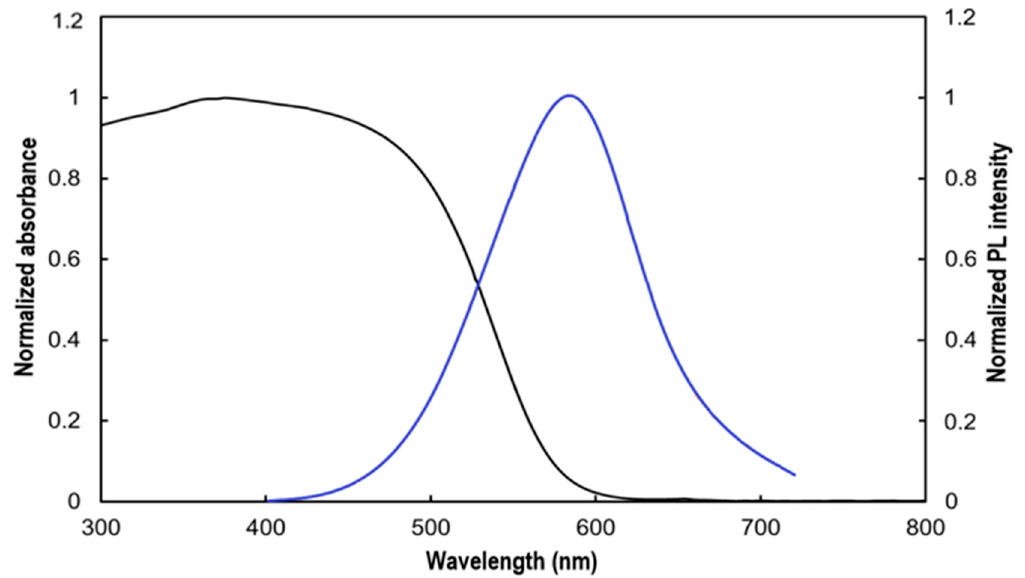
Figure 4. UV-vis absorption (black line) and fluorescence (blue line, λ exc = 370 nm) spectra of the lamellar polythiophene-silica hybrid material P4 in the solid state.